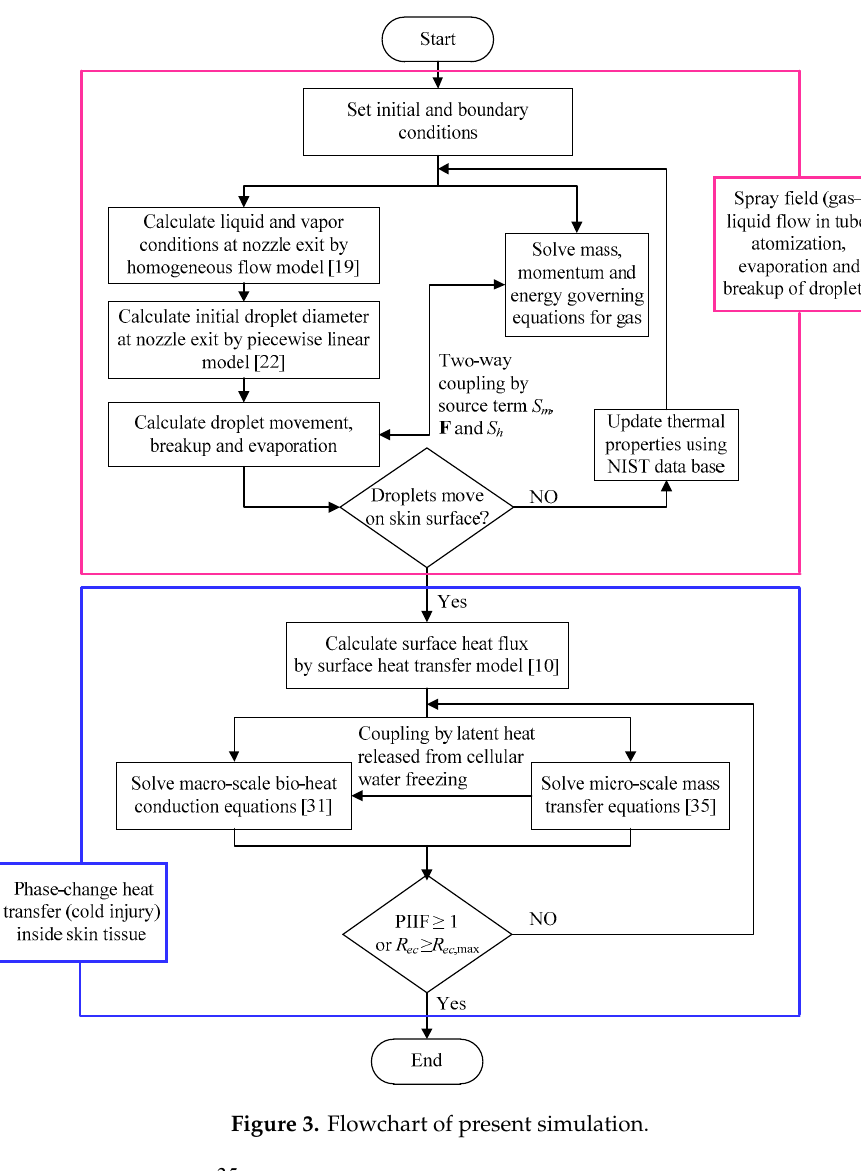
Energies 2020 , 12 , x